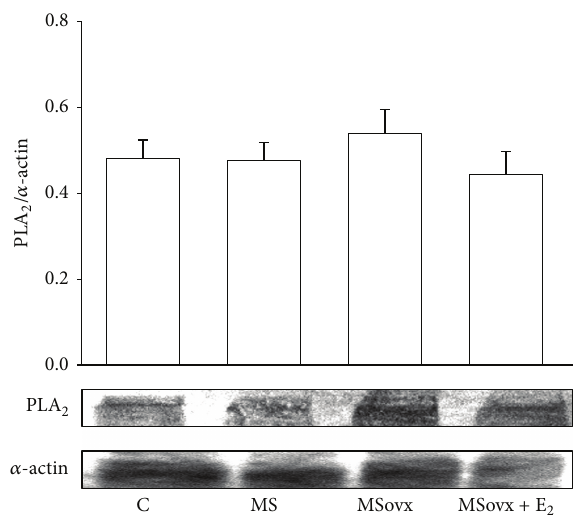
Figure 5: Representative densitometric analysis of Western blots for CYP450 4A protein expression in kidney homogenate in the experimental groups. C: control, MS: metabolic syndrome, MSovx: metabolic syndrome ovariectomized, and MSovx + E 2 : metabolic syndrome ovariectomized plus estradiol . Data are means ± SE; 𝑛 = 7 in each